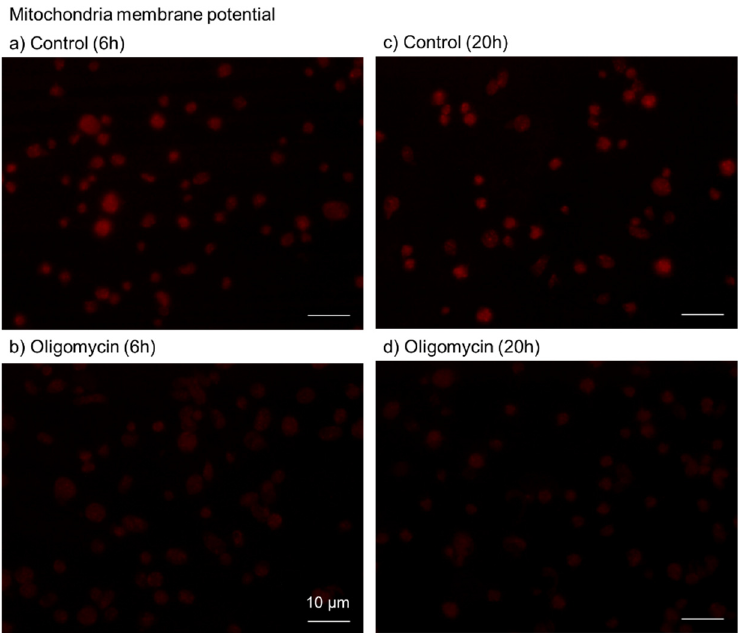
Figure 2. Effects of oligomycin on platelet membrane potential. Platelets were treated with 100 µ M oligomycin ( b , d ) for 6 h ( a , b ) or 20 h ( c , d ). The control contained only the solvent (DMSO) ( a , c ). Scale bar = 10 µ m. Similar results were observed in four other independent